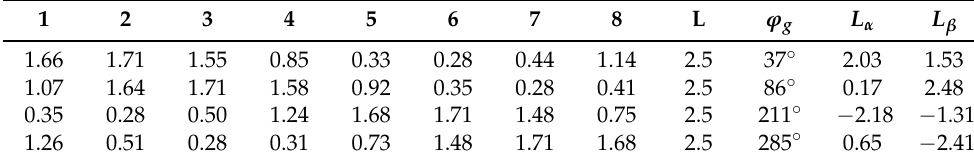
Figure 4. Two-dimensional amplitude and phase distribution of the modulated fields with the phase gradient directions ϕ g = 37 ◦ ,86 ◦ ,211 ◦ ,285 ◦ and gradient value L = 2.5. ( a ) Amplitude distribution; ( b ) phase distribution within main lobe. Table 2. Relative amplitude coefficients of the circular array